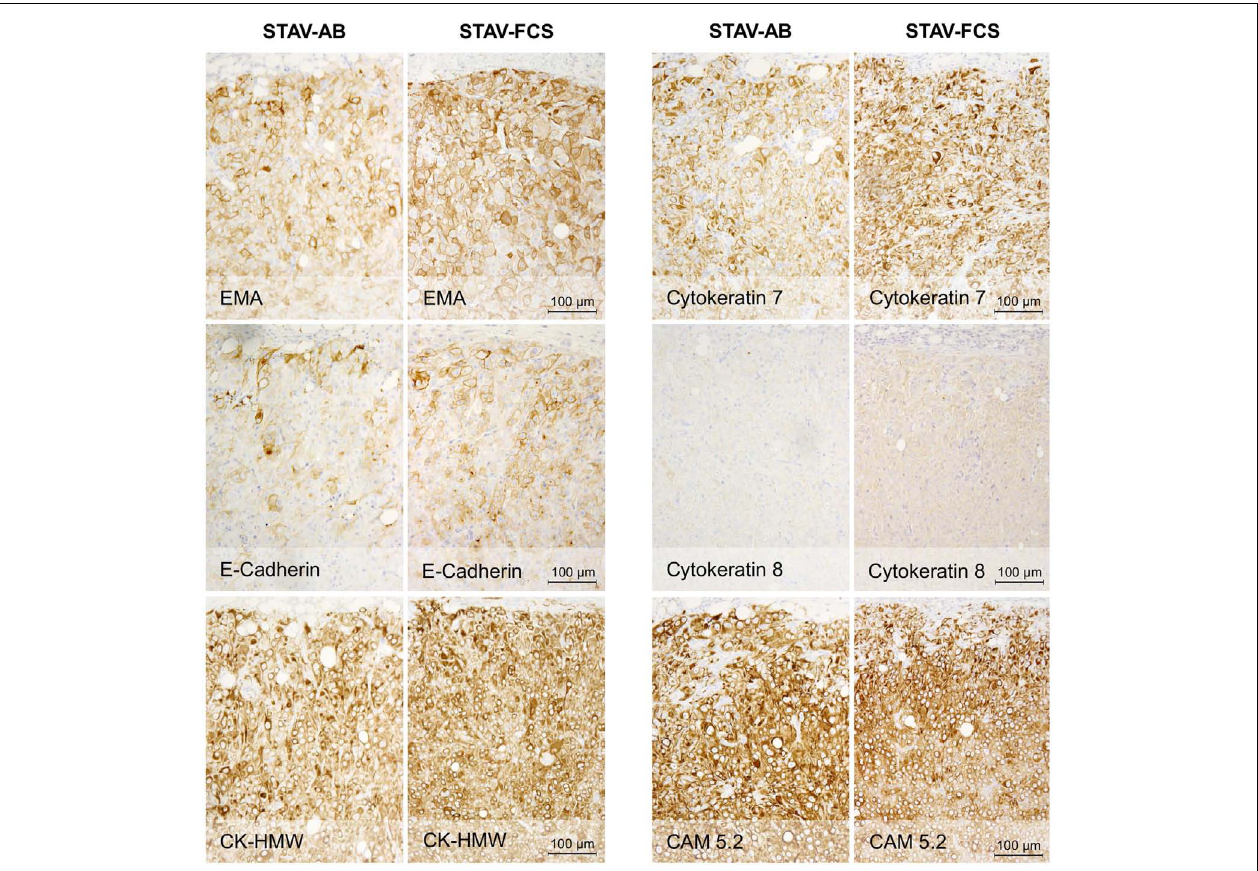
FIGURE 3 | Immunohistochemical staining of xenografts for markers of epithelial differentiation . Xenografts from both cell sub-lines stained uniformly and similarly positive for EMA, E-cadherin, CK-HMW, CK7, and CAM 5.2, and negative for CK8.These proteins are markers for epithelioid